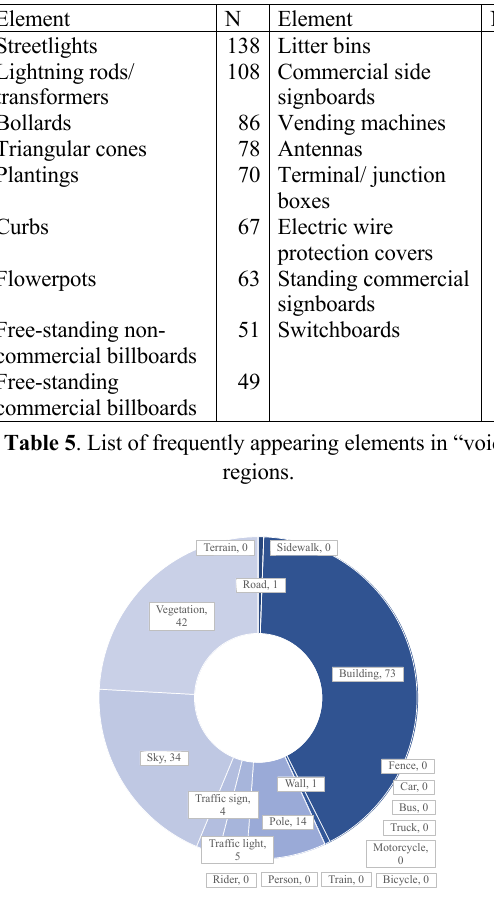
Figure 2 . Classes the streetlights were inferred as.